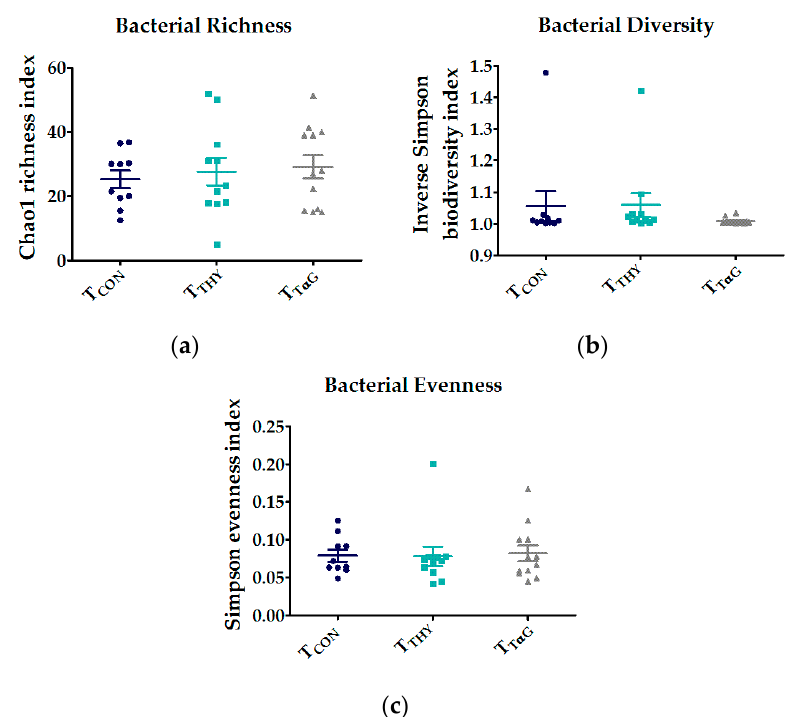
Figure 2. The alpha diversity indices of the microbial community composition on the genus level in the small intestinal contents of the last 25% of the total length of piglets fed a basal diet (T CON ) supplemented with 3.7 mmol / kg DM thymol (T THY ) or thymol α -D-glucopyranoside (T T α G ) ( a ) bacterial richness (Chao1 richness index); ( b ) bacterial diversity (Reciprocal Simpson biodiversity index; and ( c ) bacterial evenness (Simpson evenness index). The data are represented as scatter plots: each dot represents a piglet, together with the mean (middle line) and SEM (whiskers).